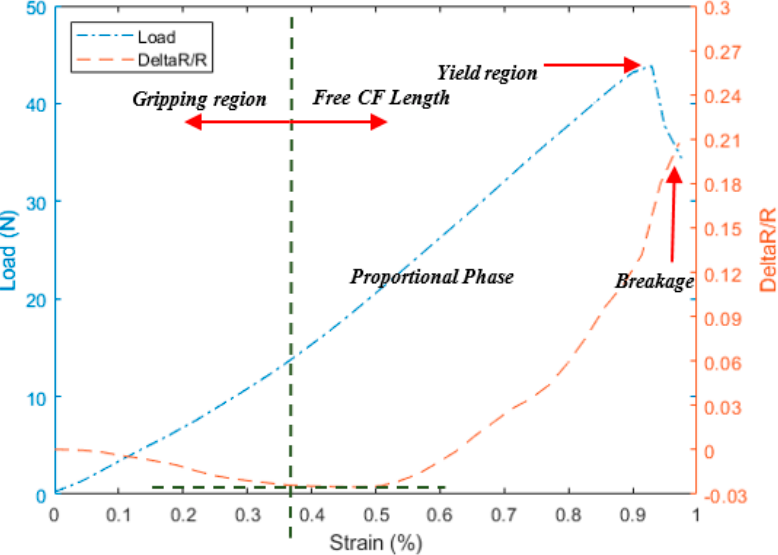
Figure 4. The tensile test for 1 K and the corresponding resistance variation measurements for configuration A.